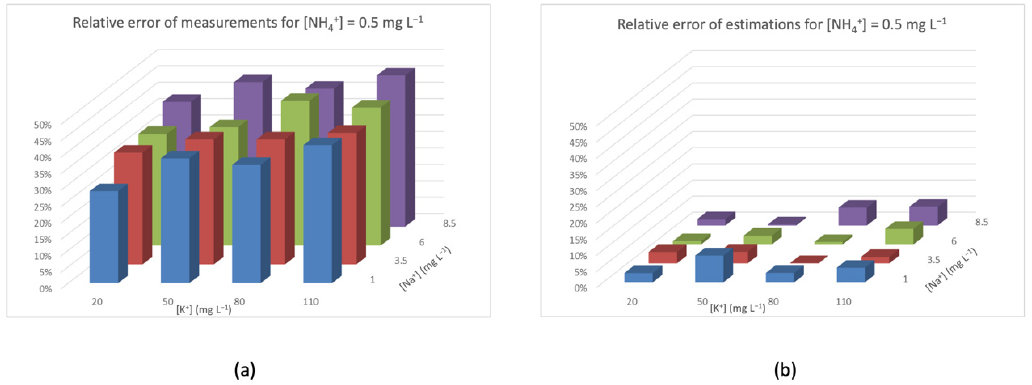
Figure 5. Relative error for [NH 4 + ] = 0.5 mg L − 1 ( a ) measured by the ISE and ( b ) after triple modular redundancy (TMR) and interference